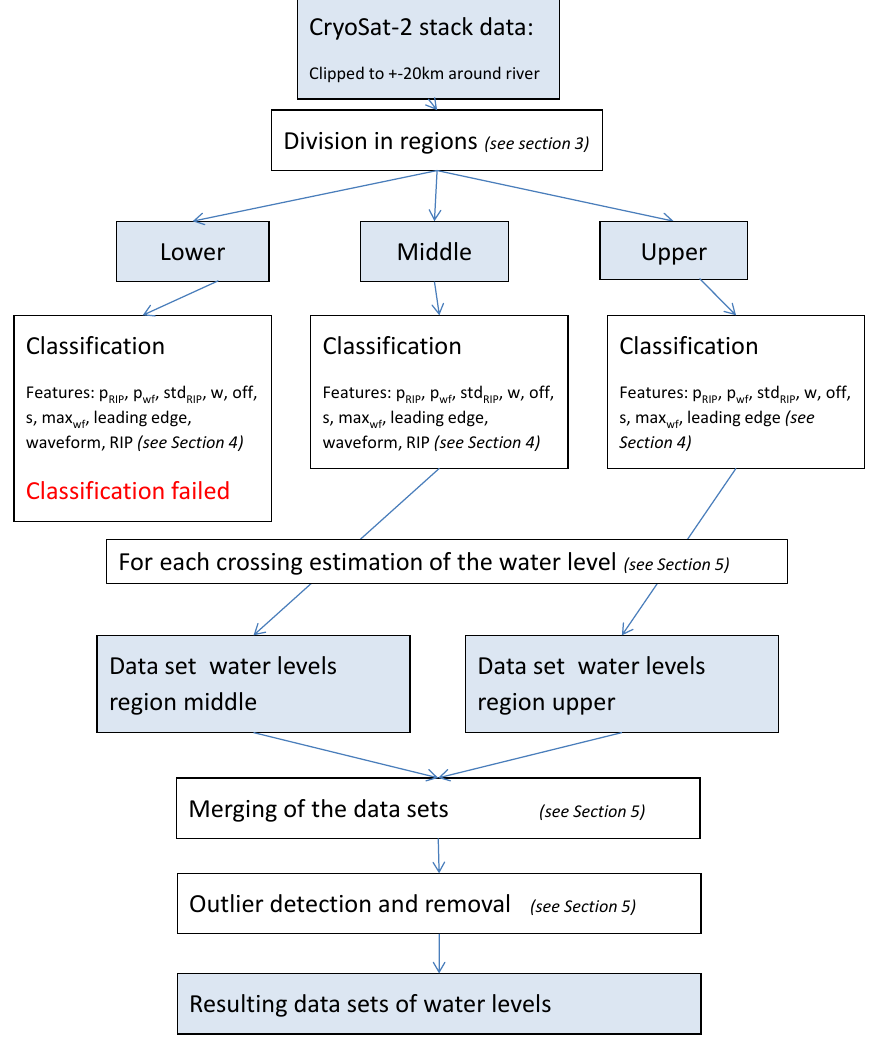
Figure 1. Processing steps used in this study for extracting water levels from the CryoSat-2 synthetic-aperture radar (SAR) data. RIP: range-integrated